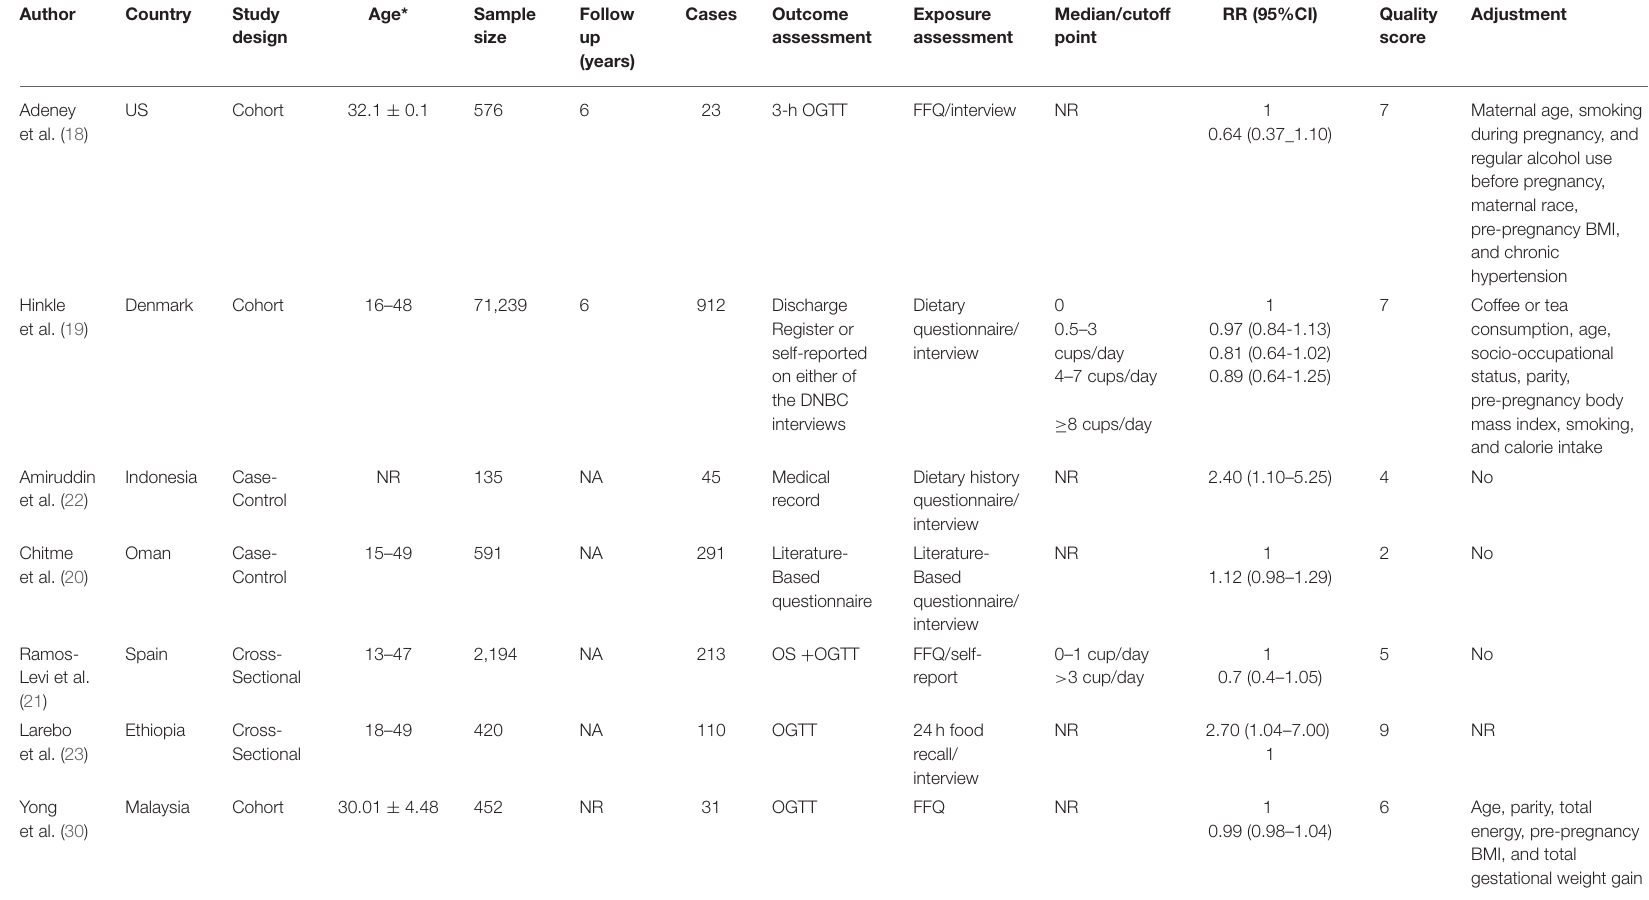
TABLE 1 | Characteristics of included studies on the association between coffee intake and gestational diabetes